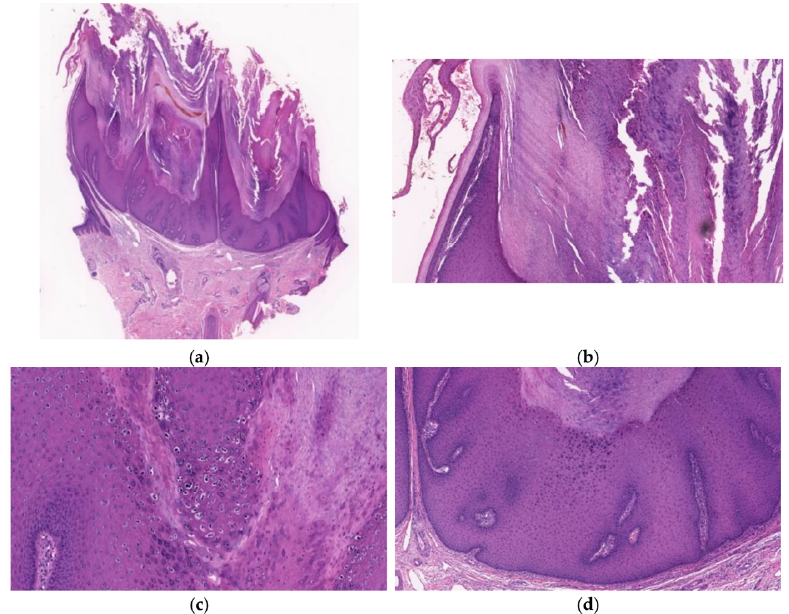
Figure 8. Histopathological findings of CFV. A crateriform configuration with finger-like exophytic projections accompanied ( a ) by epithelial lip-like structures at the periphery ( b ) is exhibited. Ar- borization is observed and the base is well demarcated without endophytic growth ( a ). Focal hypergranulosis and koilocytes are visible between the papillary projections ( c ). The lesion consists of several lobular structures composed of the proliferation of keratinocytes of a similar size and regular arrangement ( d